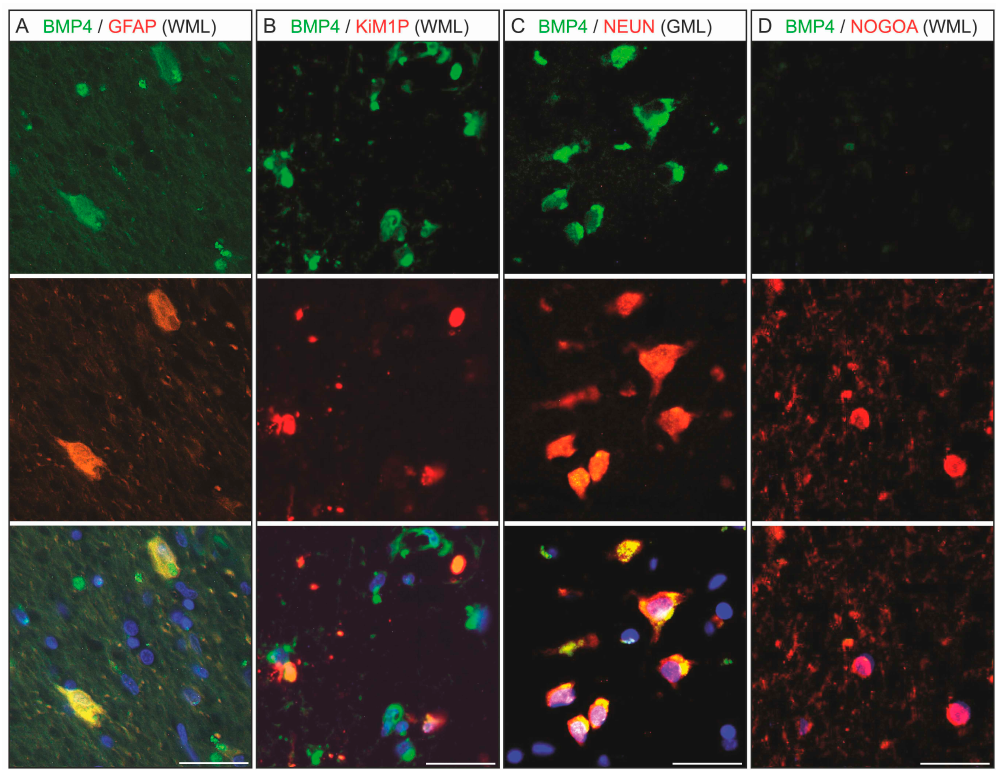
Figure 4. Chronic white matter lesions (WML) or grey matter lesions (GML) with BMP4 expressing cells. The double fluorescence staining of BMP4 ( A – D , green) with GFAP ( A , red), CD68 (Kim1P) ( B , red), and NeuN ( C , red) shows that BMP4 is expressed by astrocytes ( A ), microglia/macrophages ( B ), and neurons ( C ). The NogoA-positive adult oligodendrocytes ( D , red) do not express BMP4; (scale bar = 25 µm).